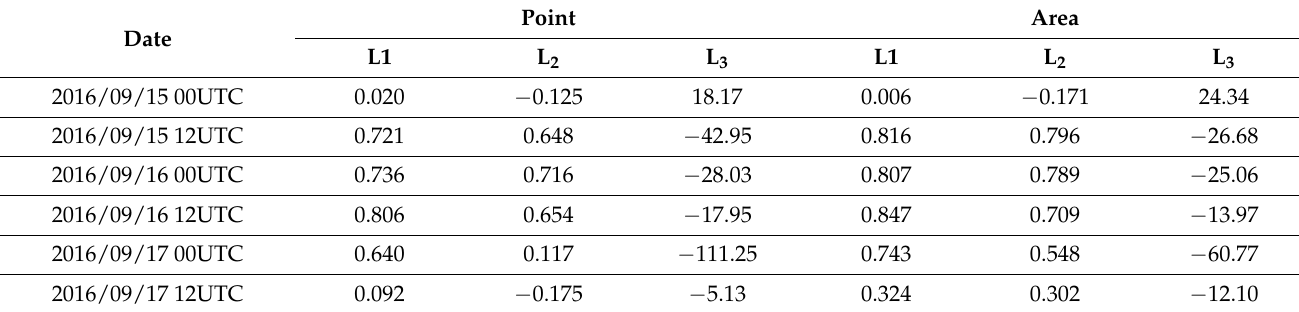
Table 3. Point and area estimates for LENS data.